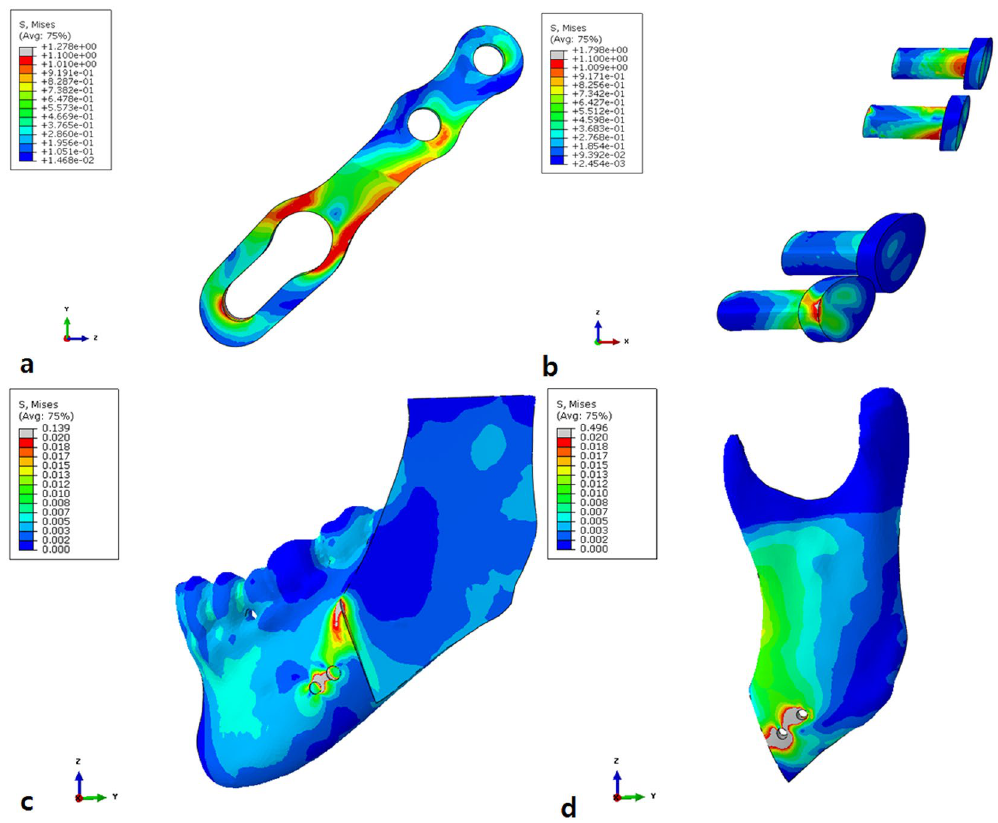
Figure 4. Finite-element model demonstrating stresses in the YK-plate with the oversized head screw model. ( a ) YK-plate, ( b ) Three screws and one oversized head screw, ( c ) Distal segment (buccal view) and (d) Proximal segment (buccal view).